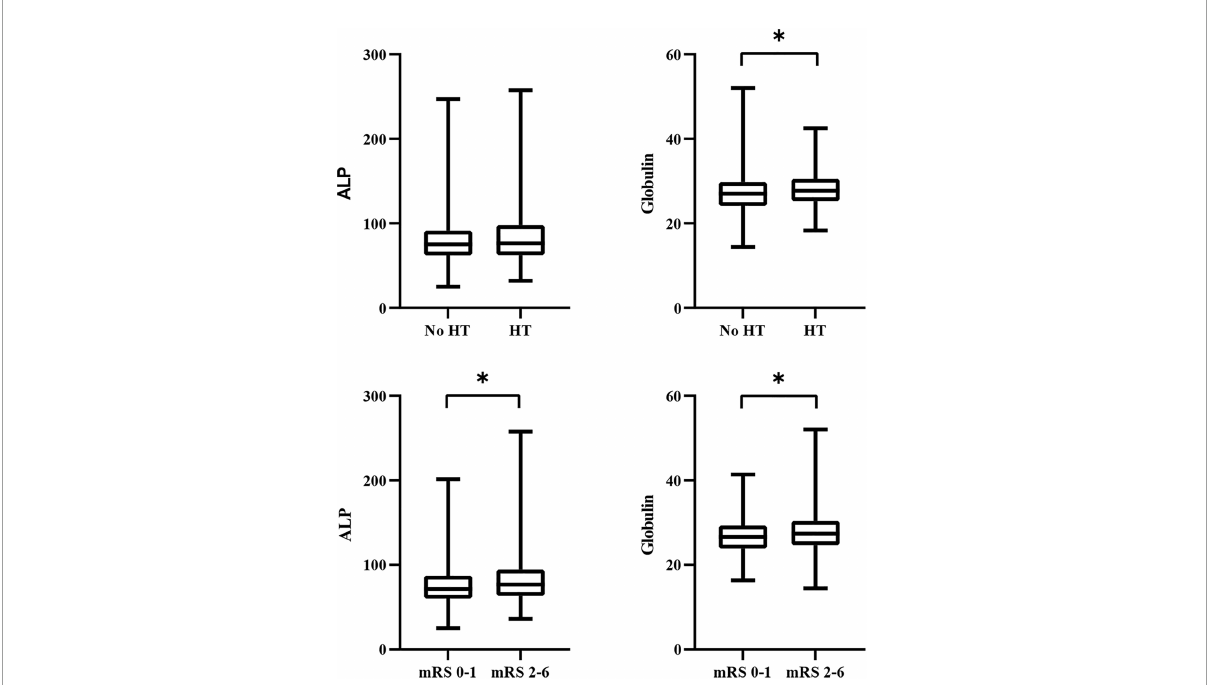
FIGURE2 Comparison of the distribution of ALP and globulin levels in clinical outcomes. ALP, alkaline phosphatase; HT, hemorrhagic transformation; mRS, modified Rankin scale. ∗ P <